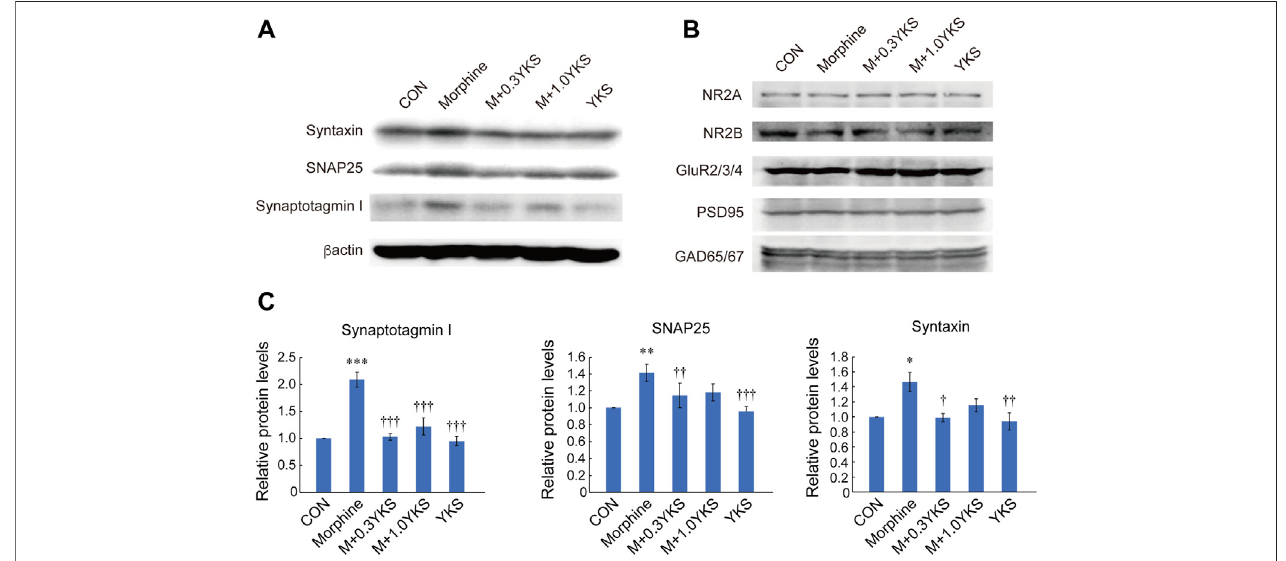
FIGURE 3 | Increased expression of presynaptic proteins in the spinal cord in conjunction with the morphine tolerance formation, which was inhibited by YKS administration. (A) PresynapticproteinlevelsatDay5inthespinalcord. (B) Therewerenosigni fi cantchangesinpostsynapticglutamatereceptorsubunits,PSD95,and GAD 65/67 protein levels at Day 5. (C) Synaptotagmin I, SNAP 25, and syntaxin levels shown in (A) were quanti fi ed. Values are the mean ± SEM ( n = 5) * p < 0.05, ** p < 0.01, *** p < 0.001 vs. CON group; †† p < 0.01, ††† p < 0.001 vs. Morphine